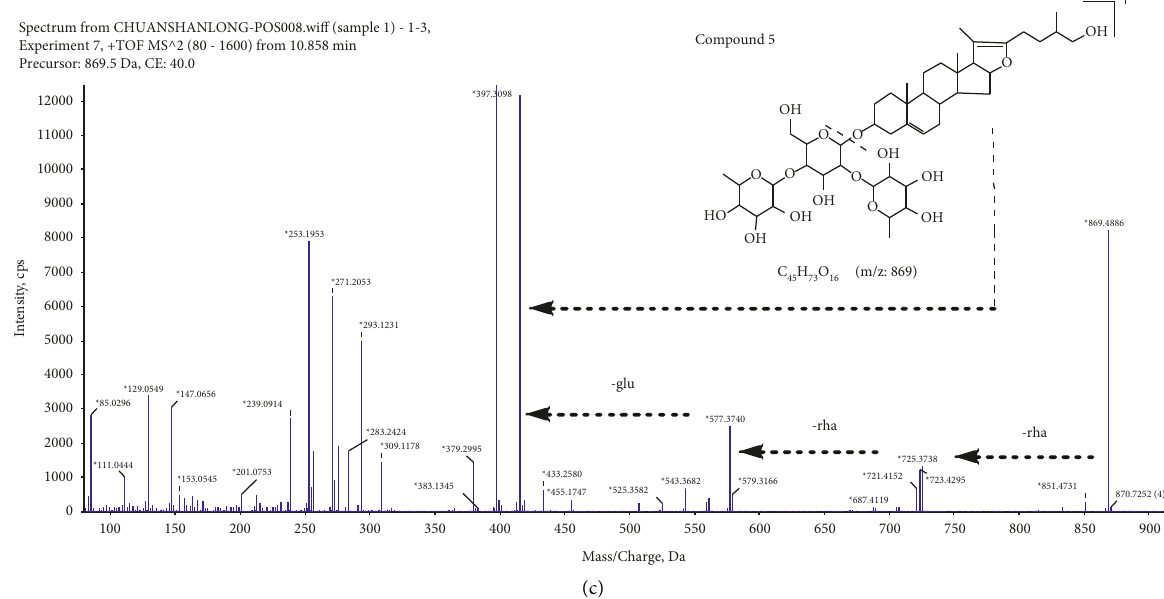
Figure 5: The MS/MS spectra of pseudoprotodioscin (a), dioscin (b), and compound 5